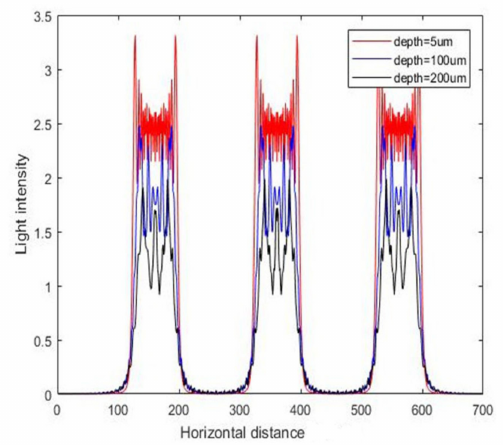
Figure 7. The intensity curve for vertical exposure with di ff erent depths.